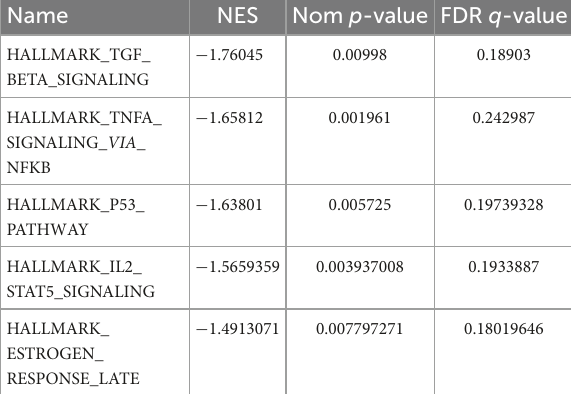
TABLE 1 The top five pathways enriched by all genes through gene set enrichment analysis (GSEA) (|NES| > 1, Nom p < 0.01, and FDR < 0.25), GSEA (gene set enrichment